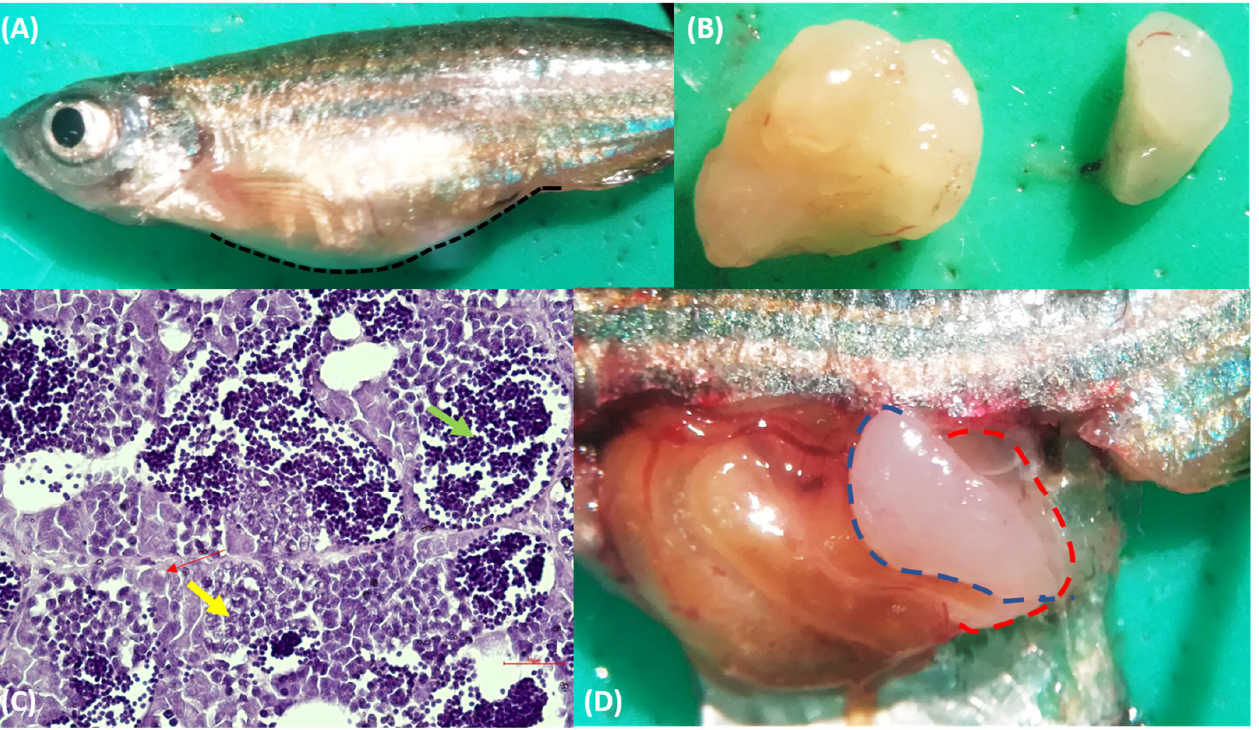
Figure 2. ( A ) Macroscopic appearance of wild-type male zebrafish of AB/TU strain, fish 2. The abdomen was considerably distended. ( B ) and ( D ) The masses filled the abdominal cavity. ( C ) Hematoxylin and eosin-stained sections from the formalin-fixed, paraffin-embedded zebrafish testis’ mass. The cells were arranged in a lobular pattern, and spermatogones (red arrow), spermatocytes (yellow arrow), and spermatids (green arrow) proliferated. Bar = 10 μ m.